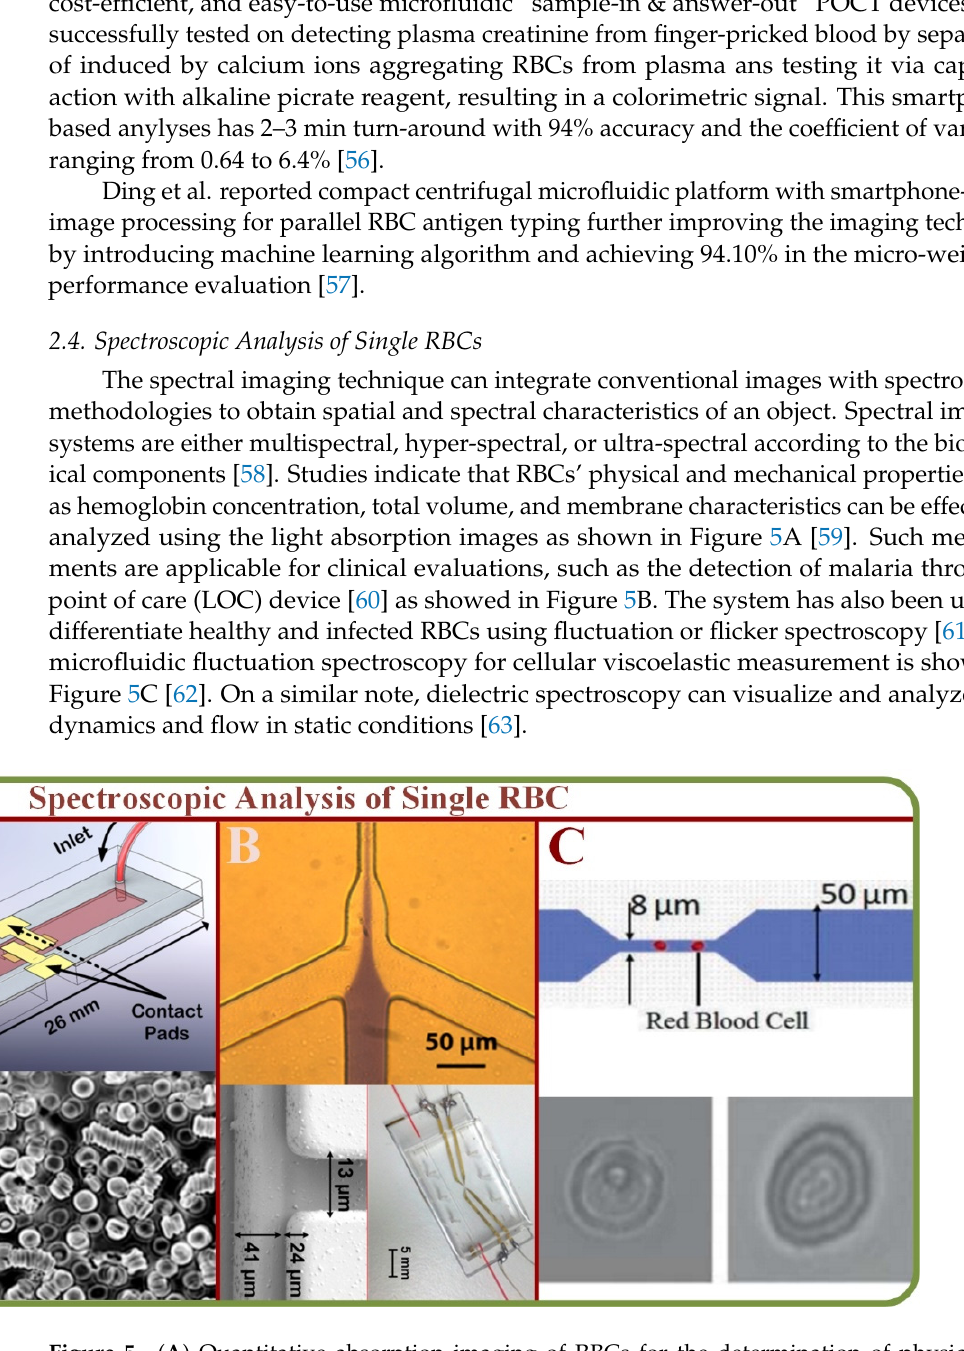
Figure 5. ( A ) Quantitative absorption imaging of RBCs for the determination of physical and mechanical properties [59]. ( B ) The optofluidic single RBC system for POC malaria diagnosis with images of healthy and infected RBCs [60]. ( C ) Microfluidic fluctuation spectroscopy for cellular viscoelastic measurement of RBCs and graphs [61,62].